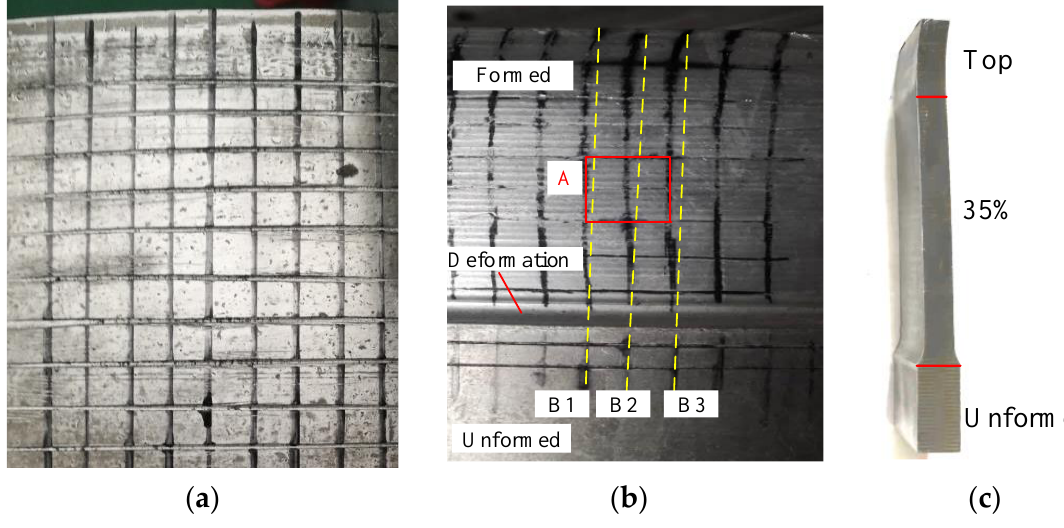
Figure 6. Tube deformation feature in the ACRFF process: ( a ) Nets on the tube blank; ( b ) Nets on the flow-formed tube (A is the sample of the deformation region; B1, B2 and B3 are Three lines in the axial direction.); ( c ) Section of the flow-formed tube. The numerical simulation tube also showed approximate deformation features. The tube stress nephogram in the ACRFF numerical simulation is shown in Figure 7a. The tube blank thickness is 10 mm. The tube thickness reduction is 35%, and the rollers’ offset position is −0.25 mm, as used in the experiment. The deformation region and the tube bottom fixed on the turntable had large Mises stress of ~245.9 MPa. Figure 7b shows the final tube net like the experiment result: the tube net was elongated in the axial direction. The deformed net in the tube top distorts to the left side of the undeformed net on the tube bottom.